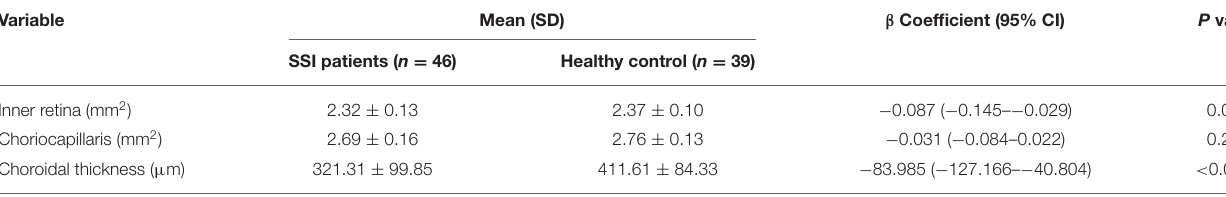
TABLE 2 | Comparison of optical coherence tomography angiography parameters between SSI patients and healthy controls. Variable